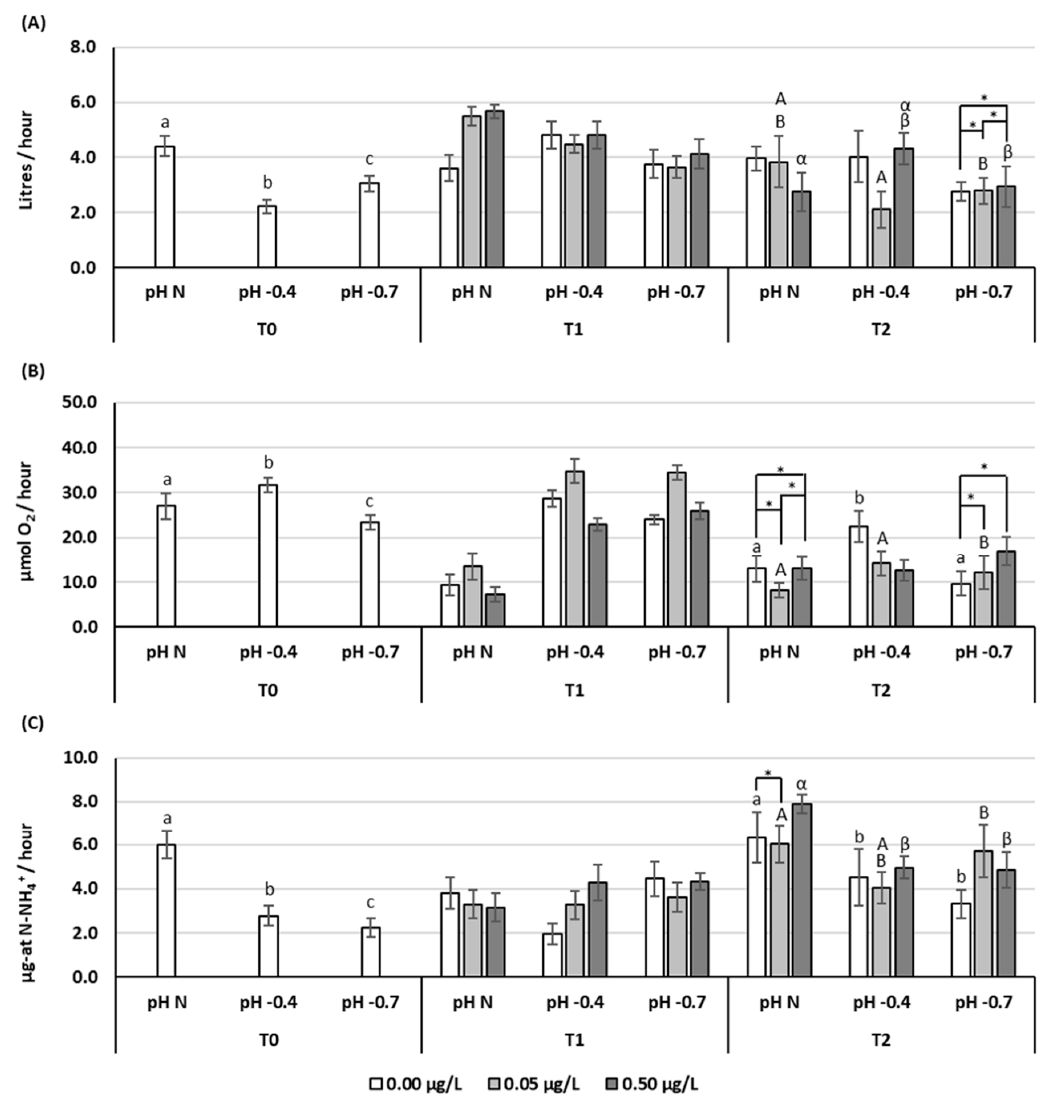
Figure 2. Clearance rate ( A ), respiration rate ( B ), and excretion rate ( C ) in M. galloprovincialis . Values are the means ± SE (n = 15). White columns refer to a diclofenac concentration of 0.00 µ g / L, light grey to 0.05 µ g / L diclofenac, and dark grey to 0.50 µ g / L diclofenac. At T0, significant ( p < 0.05) di ff erences among pH N, pH − 0.4, and pH − 0.7 are presented with lower-case letters (a–c). At T1 and T2, significant di ff erences ( p < 0.05) among pH N, pH − 0.4, and pH − 0.7 are presented with lower-case letters (a, b, and c) at the diclofenac concentration of 0.00 mg / L, with capital letters (A, B, and C) at the diclofenac concentration 0.05 mg / L, and with Greek letters ( α and β ) at the diclofenac concentration of 0.50 mg / L. At each pH value, asterisks represent significant ( p < 0.05) variations among di ff erent diclofenac